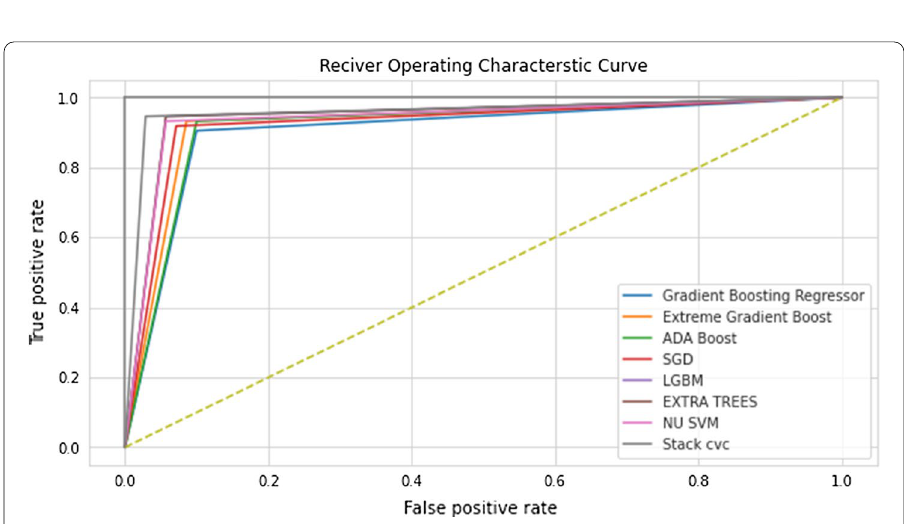
Fig. 5 ROC curve of UCI heart disease